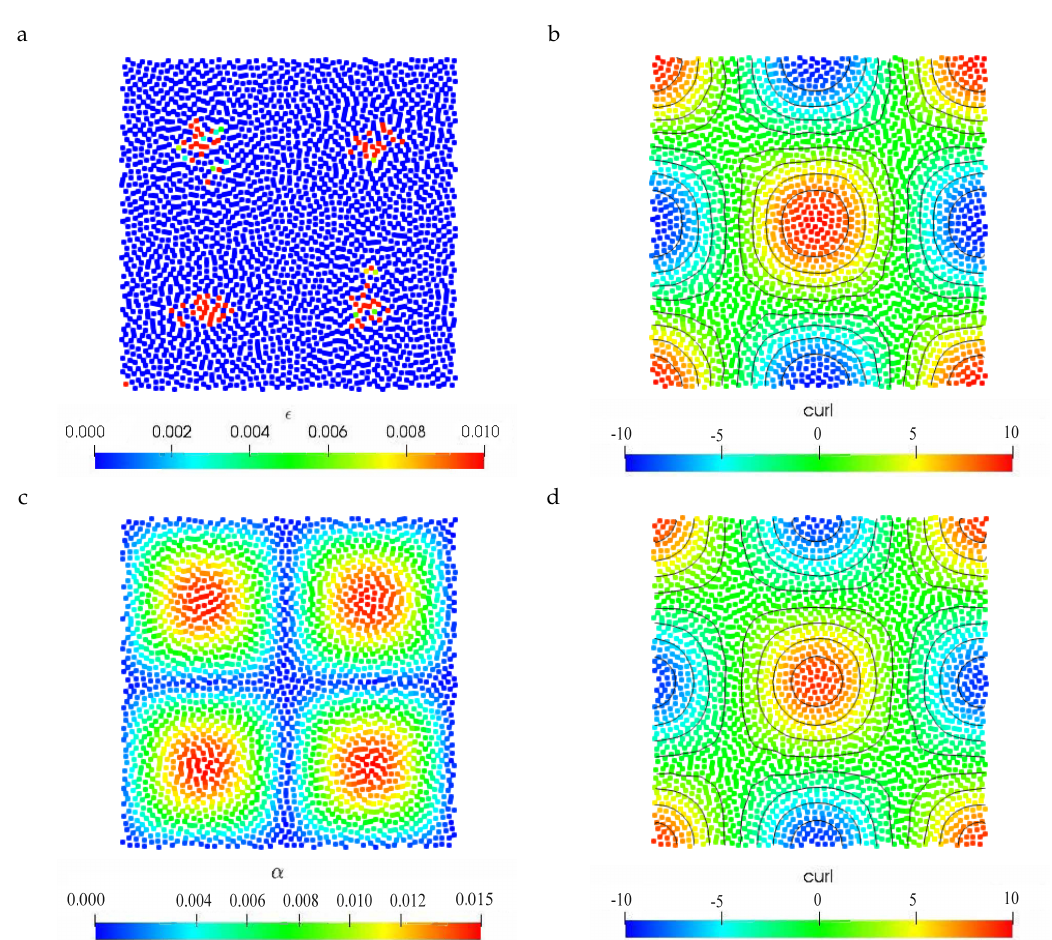
Figure 2. Two-dimensional Taylor–Green flow at Re = 1000. On the top, the viscosity parameter ( (cid:101) ) ( a ) and the vorticity field ( b ) obtained with the proposed δ -ADA-SPH scheme. On the bottom we show the value of the α parameter ( c ) and the vorticity field ( d ) using the δ -LES-SPH. Results obtained at t = 3.